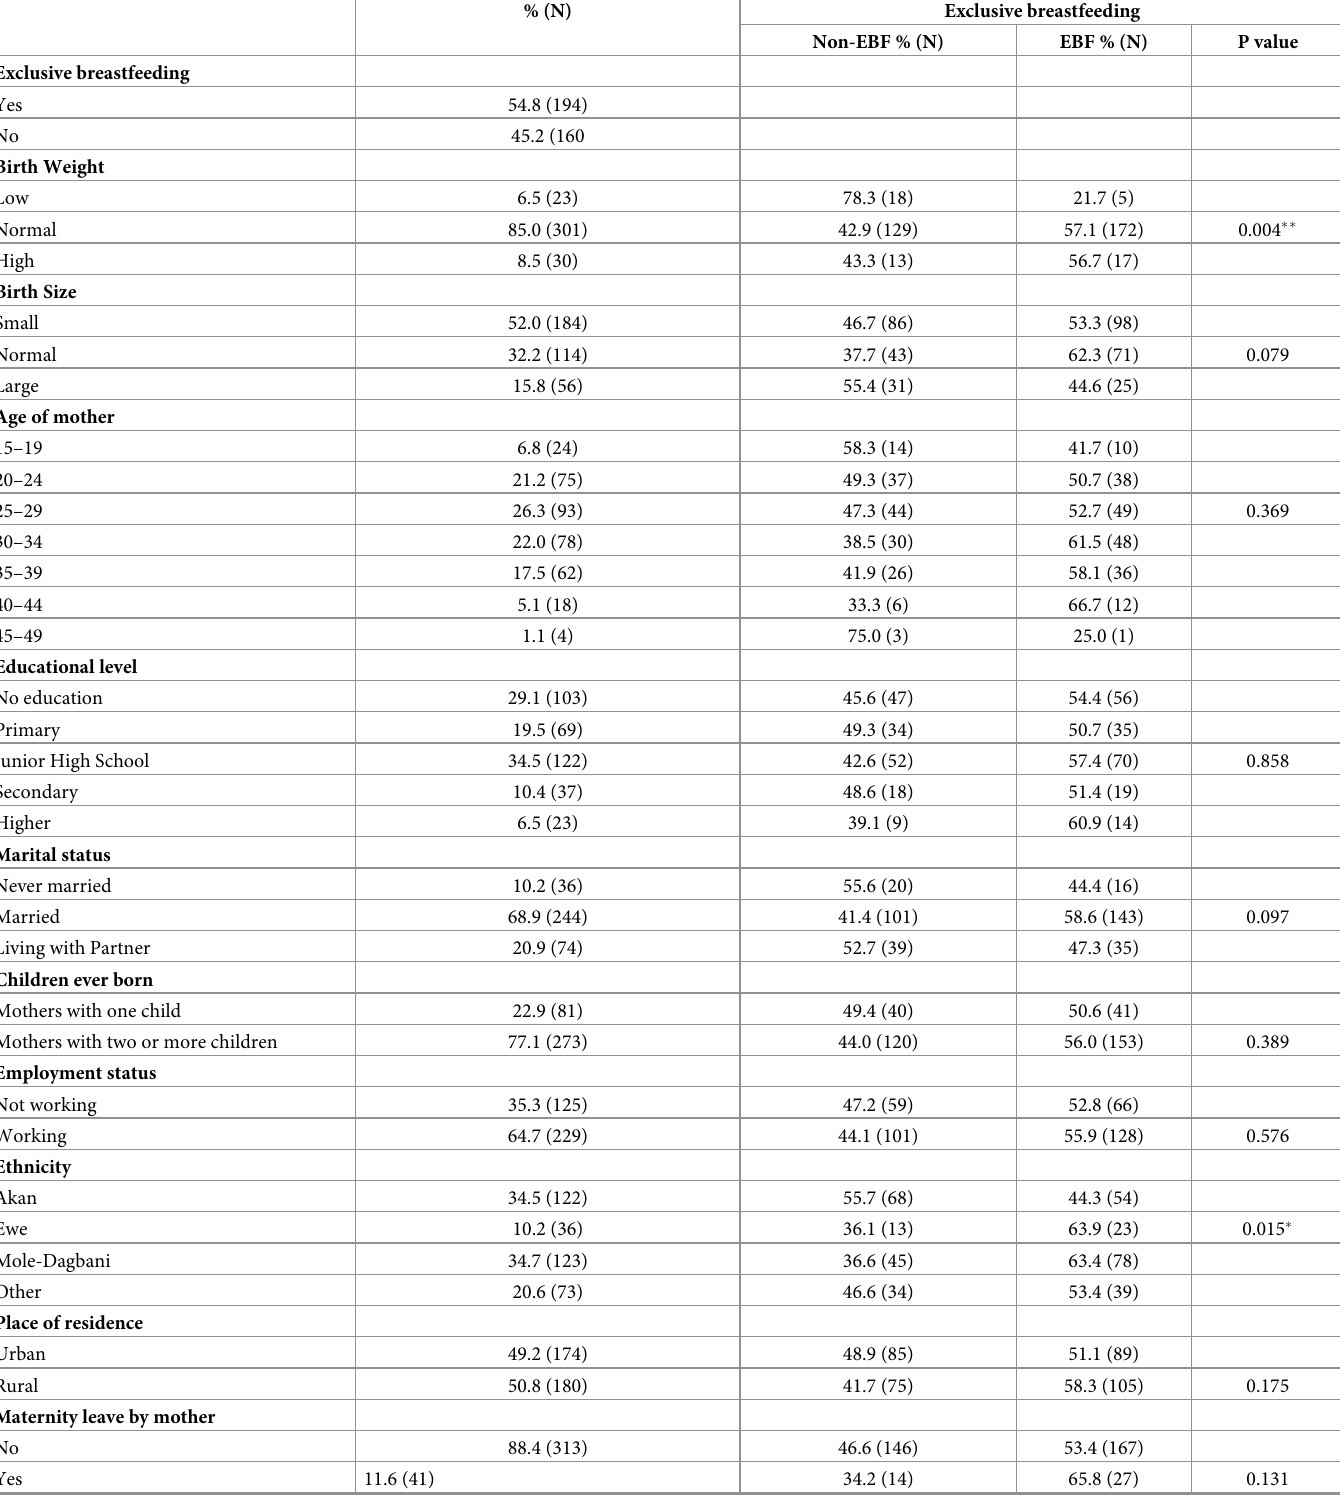
Table 1. Background characteristics of mothers and infants in the study (N =